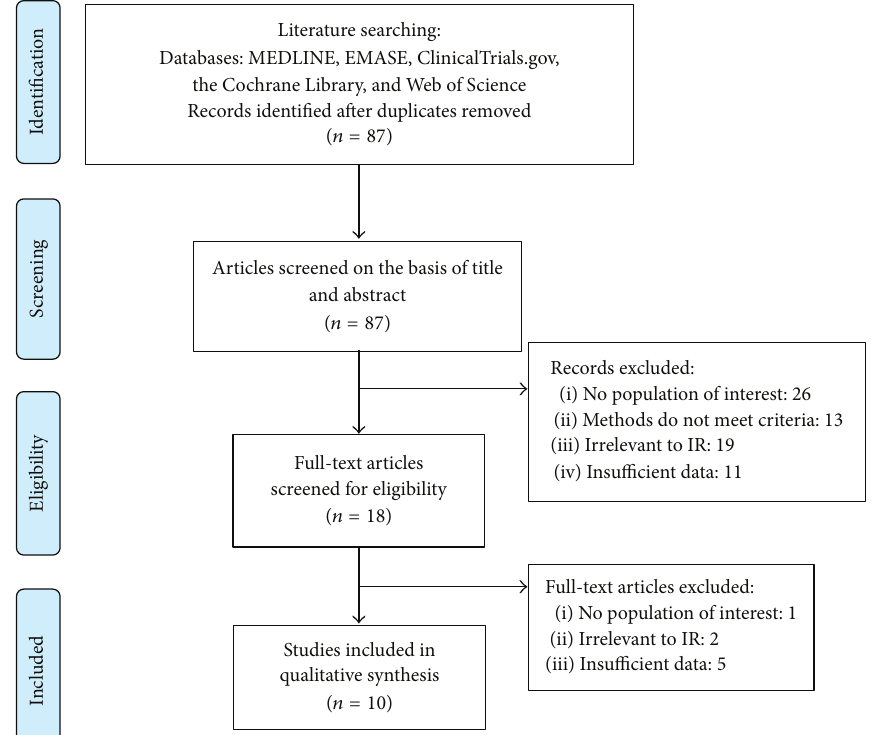
Figure 1: The flowchart of literature selection in this